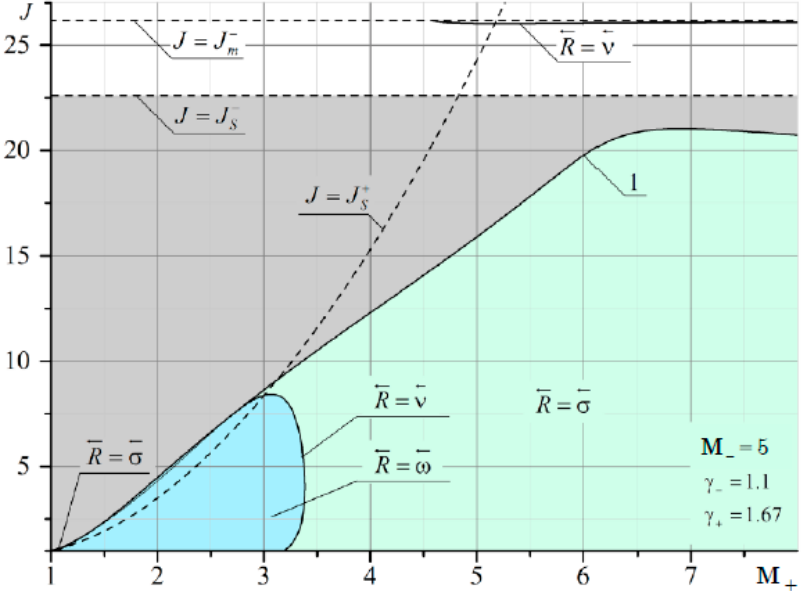
Figure A6. Domains of existence of reflected discontinuities for refraction from a gas consisting of combustion products into a monatomic gas. The Mach number of the flow from which the shock comes is M – = 5. The domains of existence of reflected discontinuities for refraction in a flow of diatomic gas at the Mach number of the flow M – = 2 are shown in Figure A7.